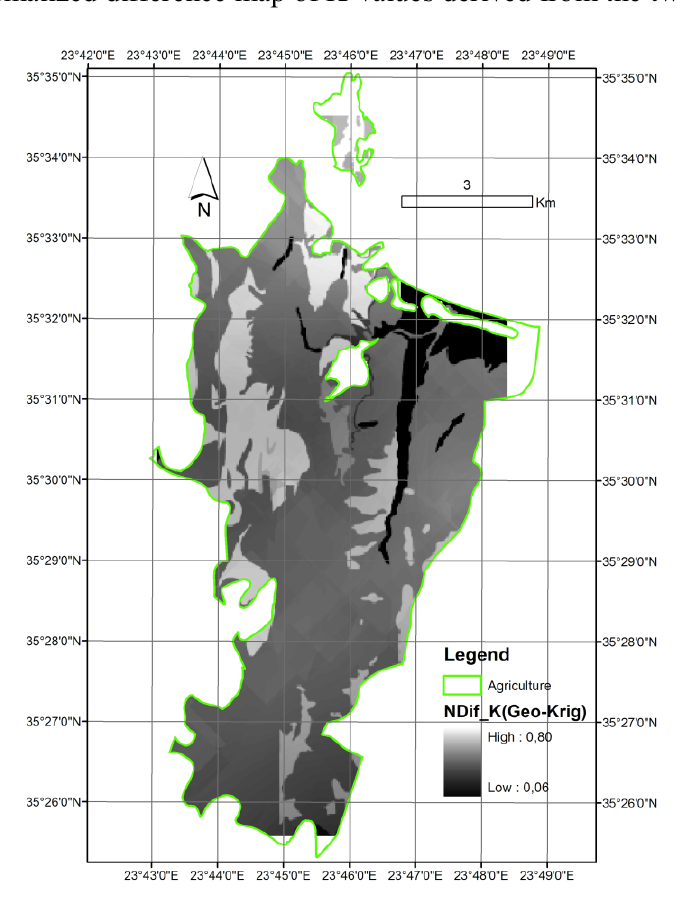
Figure 8. Normalized difference map of K-values derived from the two